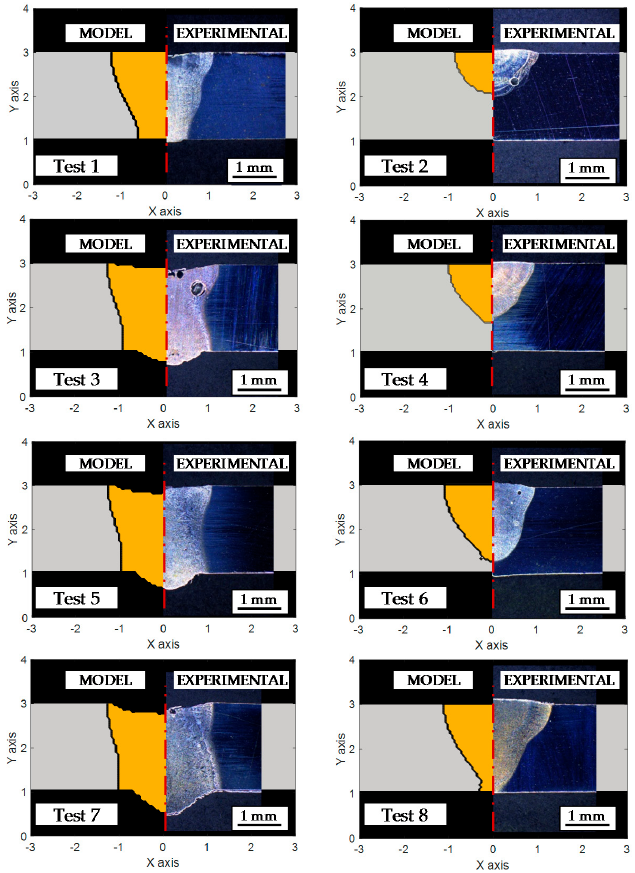
Figure 11. Comparison between the modeled and the analyzed cross sections (tests parameters described in Table 3).